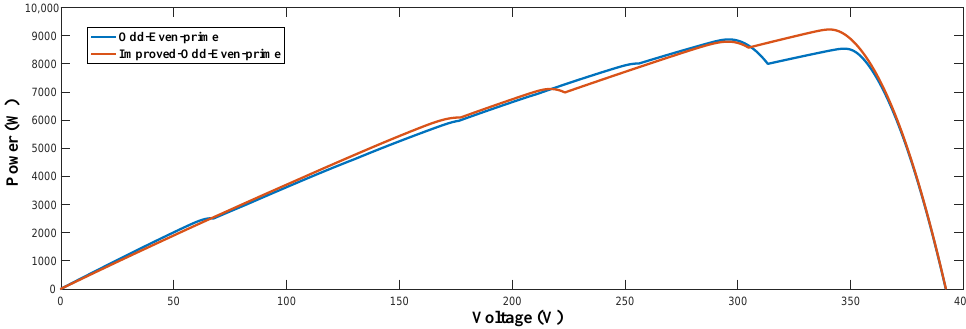
Figure 11. Voltage–power characteristics of 9 × 9 PV array for case-5 (Top-Left and Bottom-Right) PSC. For different values of array current, the array voltage and power are calculated and noted in Table 6. From Table 6, it is clearly understood that the maximum value of power for OEP is 48 V m I m and the maximum value of power for IOEP is 48.6 V m I m